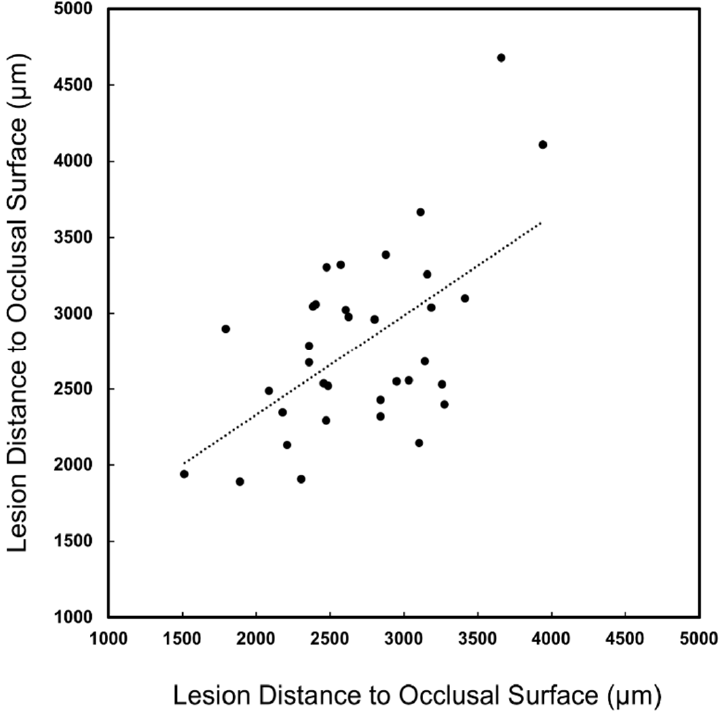
Figure 6. Depth below the occlusal surface measured in transillumination mode (Z ot ) and microCT (Z µ ) There was a significant correlation between the two methods ( p < 0.05) with R 2 = 0.33 and 34 of the 67 lesions had sufficient contrast to perform the measurements.